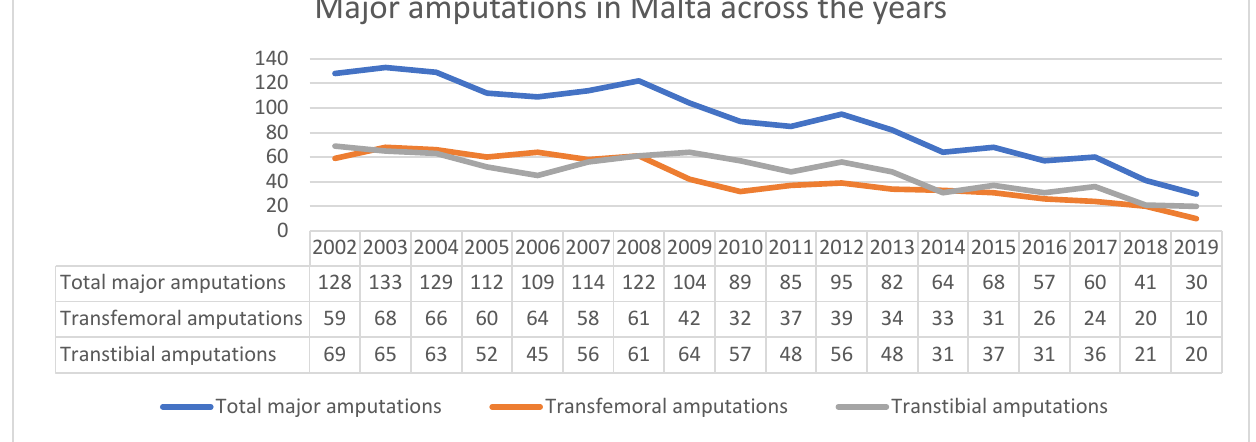
Figure 3. Number of major amputations over the years. Specialist vascular service was introduced in 2007 and became fully established in 2014.